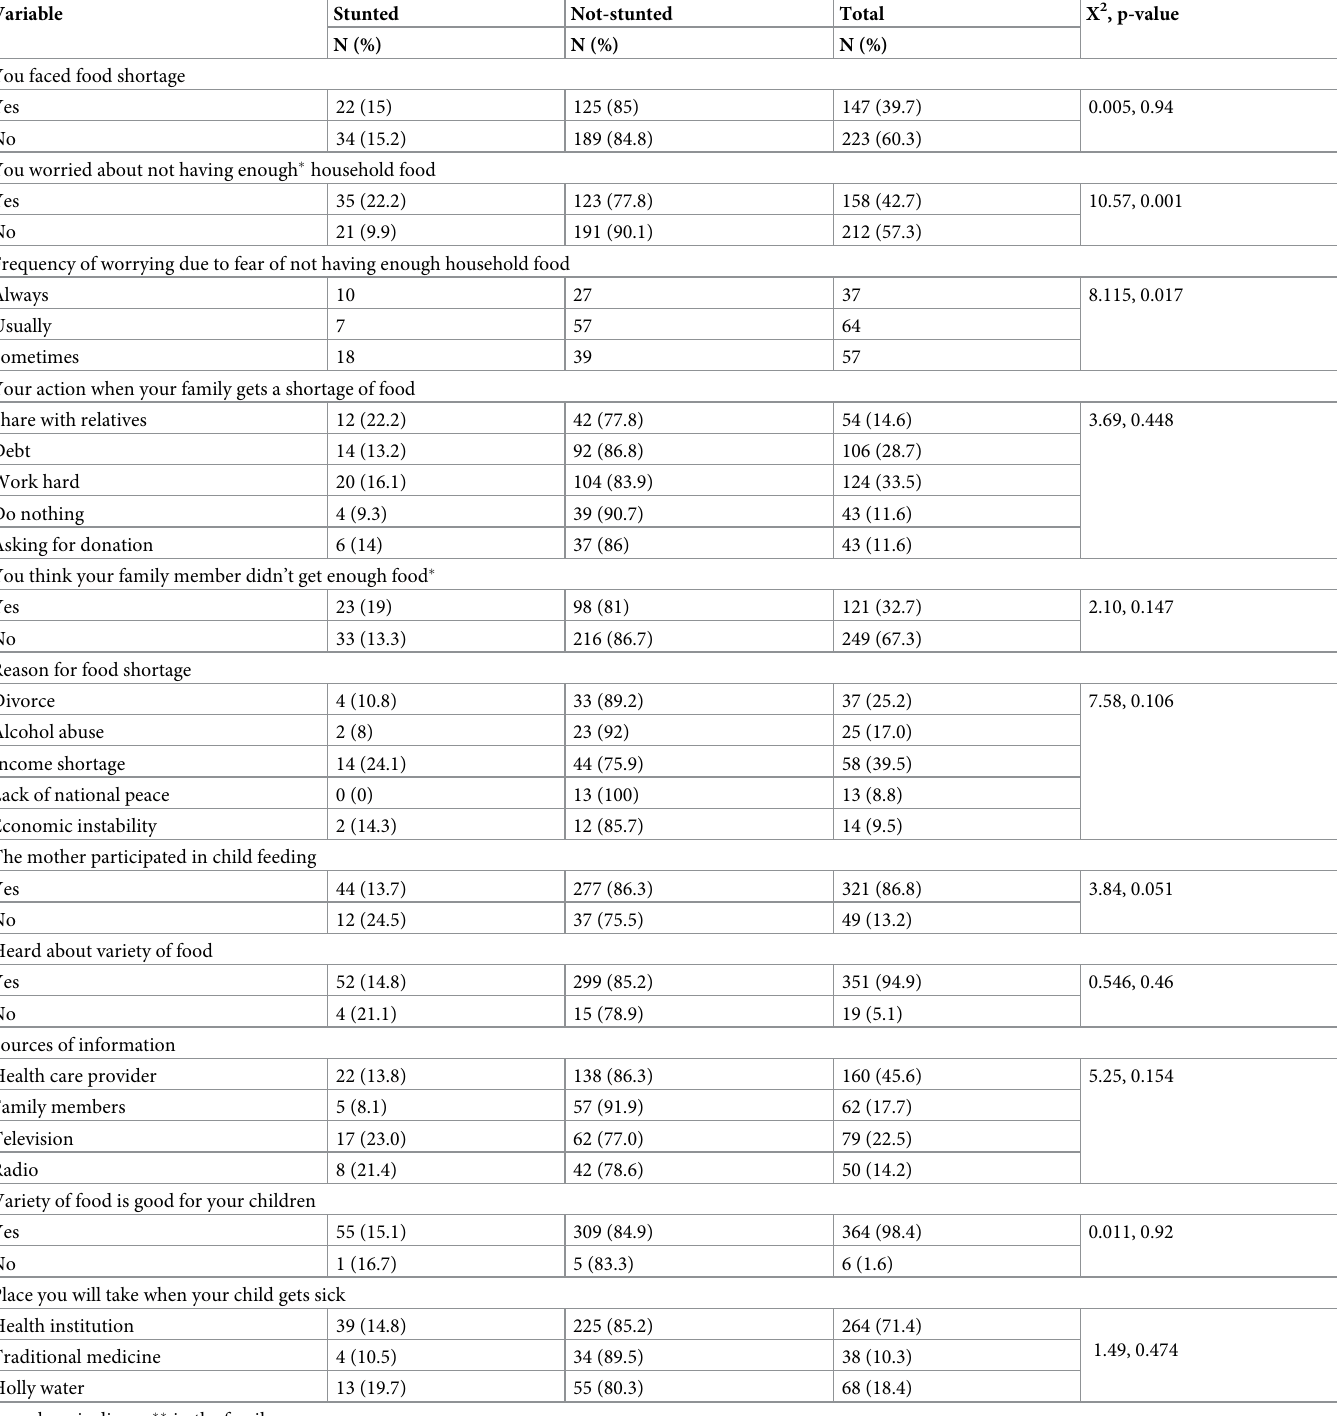
Table 2. The relationship of household food security, dietary diversification, and stunting among Bahir Dar city public primary school pupils, North West Ethiopia, 2019.